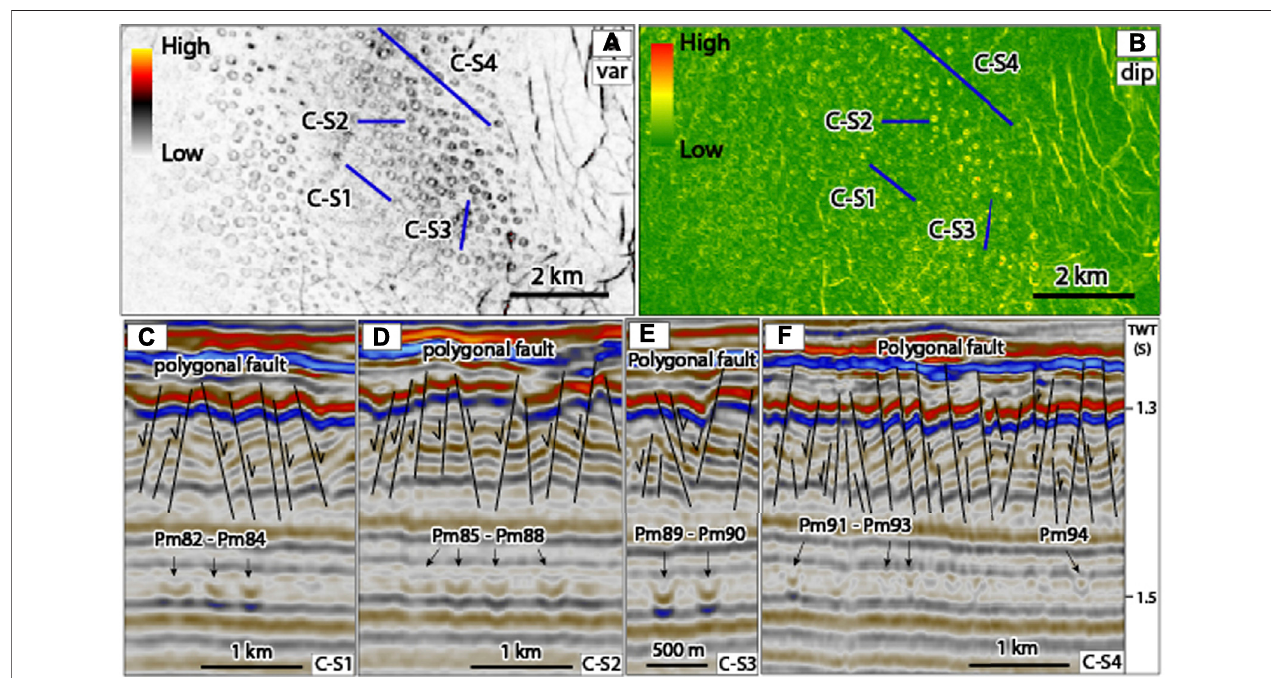
FIGURE11|(A) Thevariancemapshowingsub-roundtoround-shapedpockmarksonthetopviewwithlowtomediumvalues(0.3 – 0.5)ofdiscontinuity,while (B) the consistent dip map shows slope angles of paleo-pockmark walls between 4 and 7 ° (low to medium value). (C – F) Seismic sections C-S1 to C-S4 show the shape of 13 paleo-pockmarks (Pm82 — Pm94) in pro fi le view, as V- and U-shaped pockmarks with a size range from 163 to 281 m width and 16 – 37 ms (TWT) depth. The polygonal fault system is observed over the paleo-pockmark